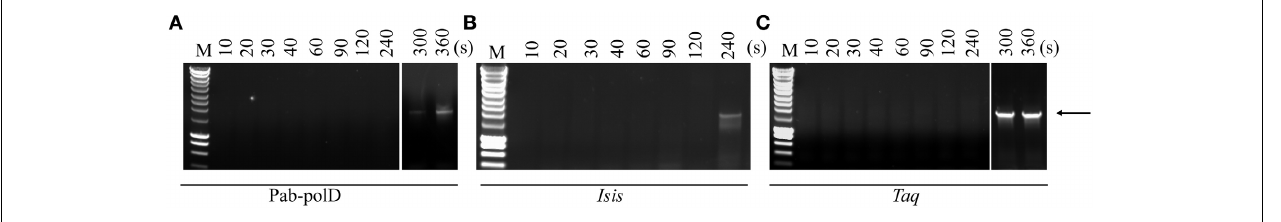
FIGURE 4 | Rate of DNA extension. PCR amplification of the 1.95kb target ( Table 1 )wascarriedoutwith0.1UofPab-polD (A) ,1UofPab-polB (B) ,and1U of Taq-polA (C) in their respective reaction buffer ( Table 2 ). PCR program was